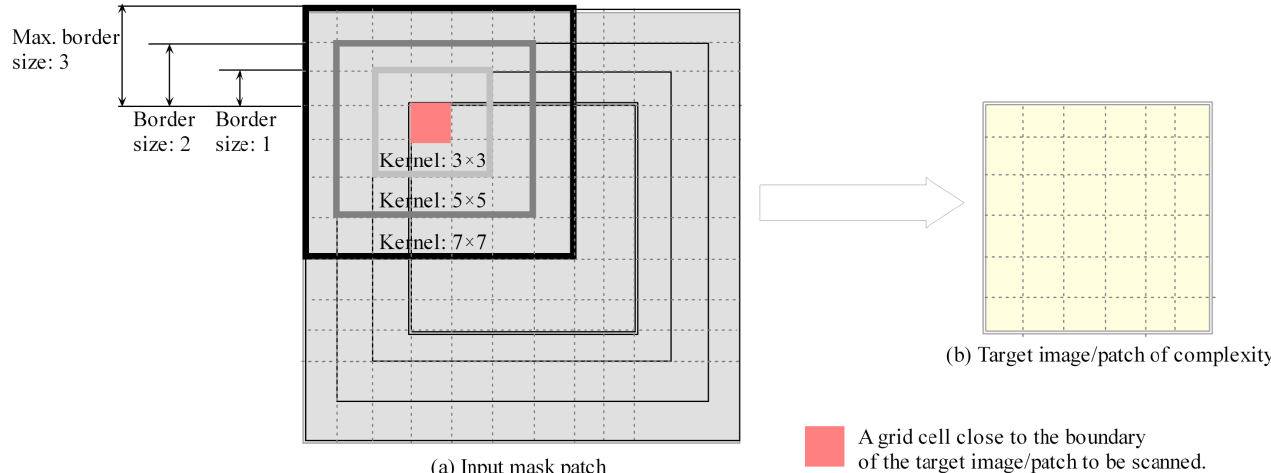
Figure 1. Multiscale convolution operator by different kernel sizes.